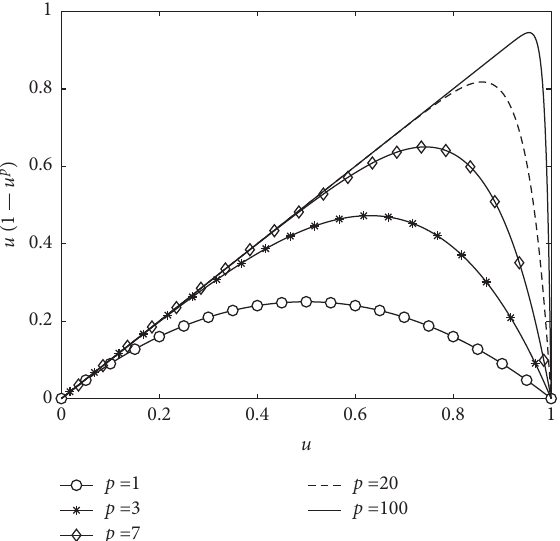
Figure 2: Nonlinear part u ( 1 − u p ) of equation (1) for p � 1 , 3 , 7 , 20, and